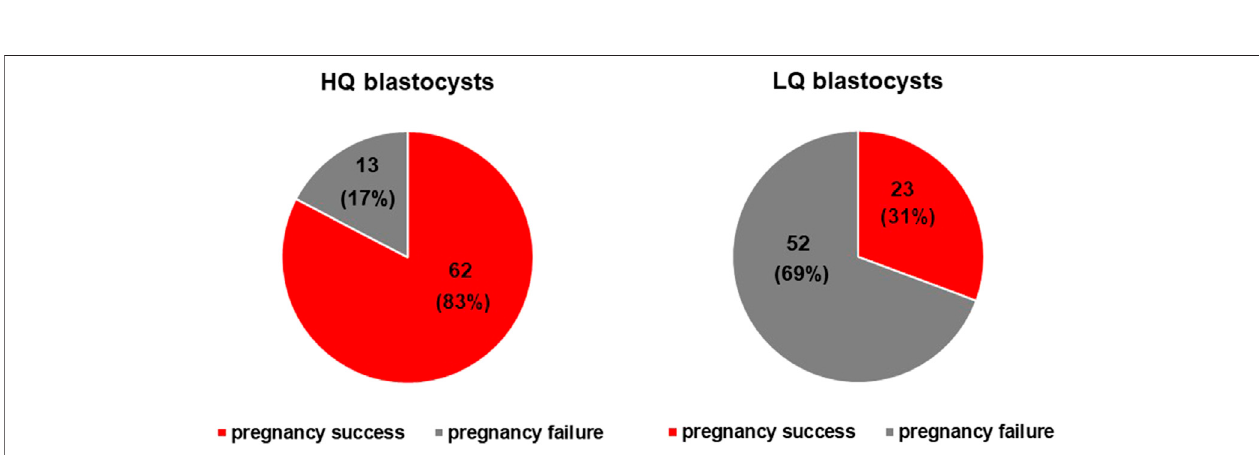
FIGURE 6 | The observation of a connection between blastocyst development and pregnancy outcome. A one-on-one observations of blastocyst development andpregnancyoutcomeswasmade.Thereareatotalof150transferrableblastocystsofPCOSpatients,including75high-qualityblastocysts( ≥ 4BB)and75low-quality blastocysts ( ≥ 3BC and ≤ 4BC). Of the 75 high-quality blastocysts, 62 successfully conceived, and the clinical pregnancy rate was about 83%. That is, even if a high- quality blastocyst was transplanted, 17% of patients failed to conceive. On the other hand, of the 75 low-quality blastocysts, 23 successfully conceived, and the clinical pregnancy rate was about